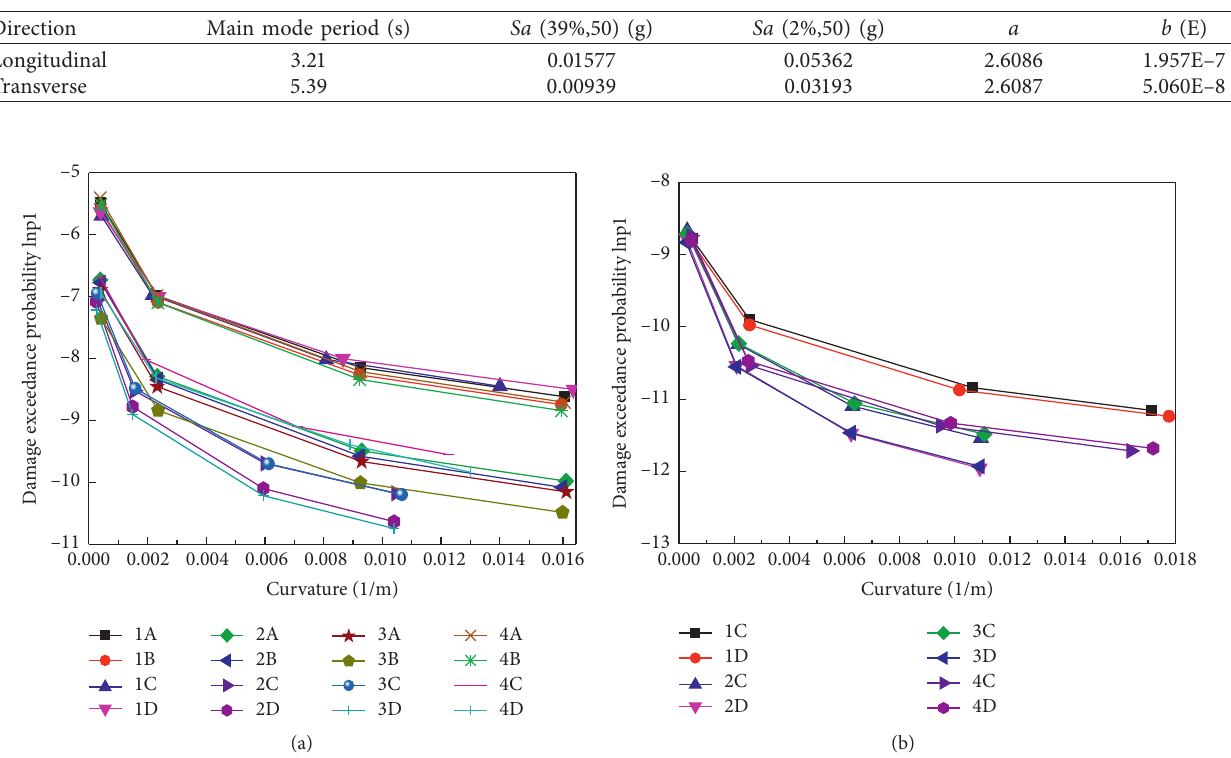
Table 7: Calculated values for the relevant parameters of the seismic hazard function.